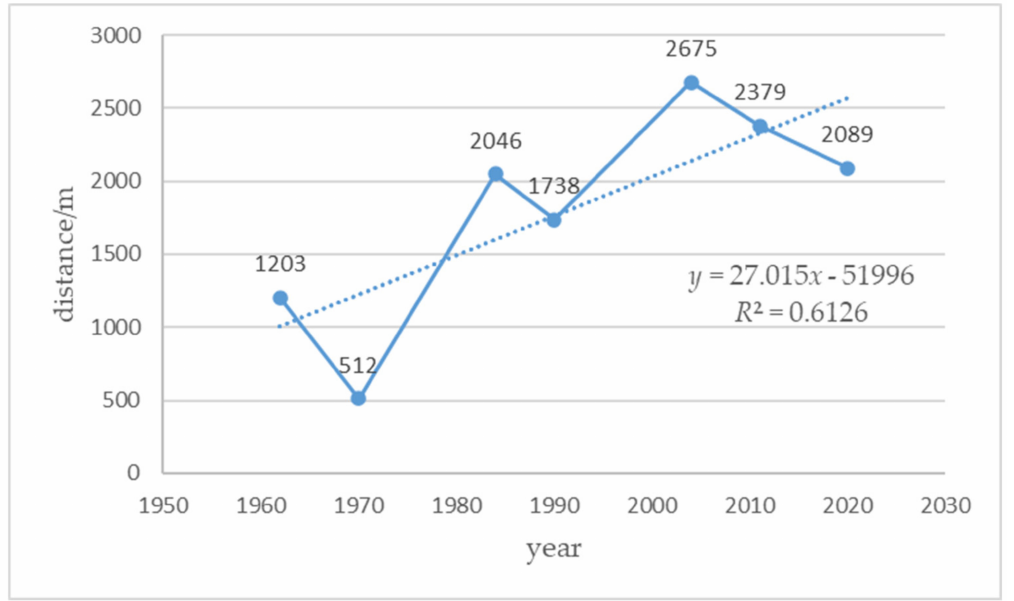
Figure 14. Change in the distance between the SHS site and the southern bank of the Yellow River from 1960 to